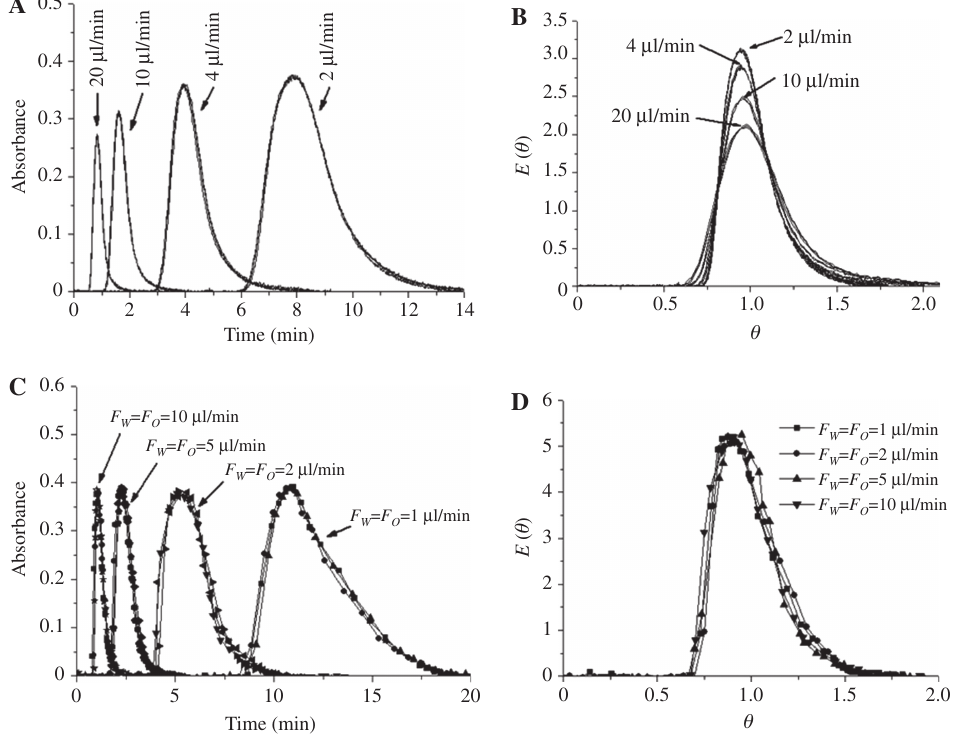
Figure 8 RTD measurements of mineral oil and seawater flows. (A) Absorbance as a function of time for seawater injections and (B) their corresponding E( θ ) values as a function of dimensionless time ( θ ). (C) Absorbance as a function of time for mineral oil-seawater multiphase flows and (D) their corresponding E( θ ) values as a function of dimensionless time ( θ ).